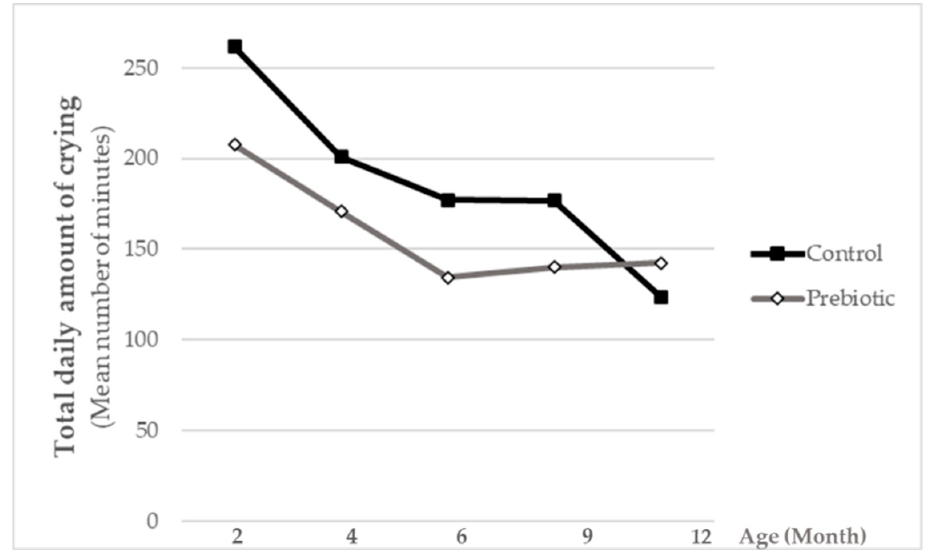
Figure 4. Total daily amount of crying presented as the mean number of minutes. Statistical differences between groups were analyzed via the generalized estimating equation (GEE) approach. The presence of digestive symptoms is shown in Supplementary Table S6. Measure- ments related to digestive tolerance (number of regurgitations/day, number of vomits/day, presence of flatulence or meteorism) were not different between prebiotic and